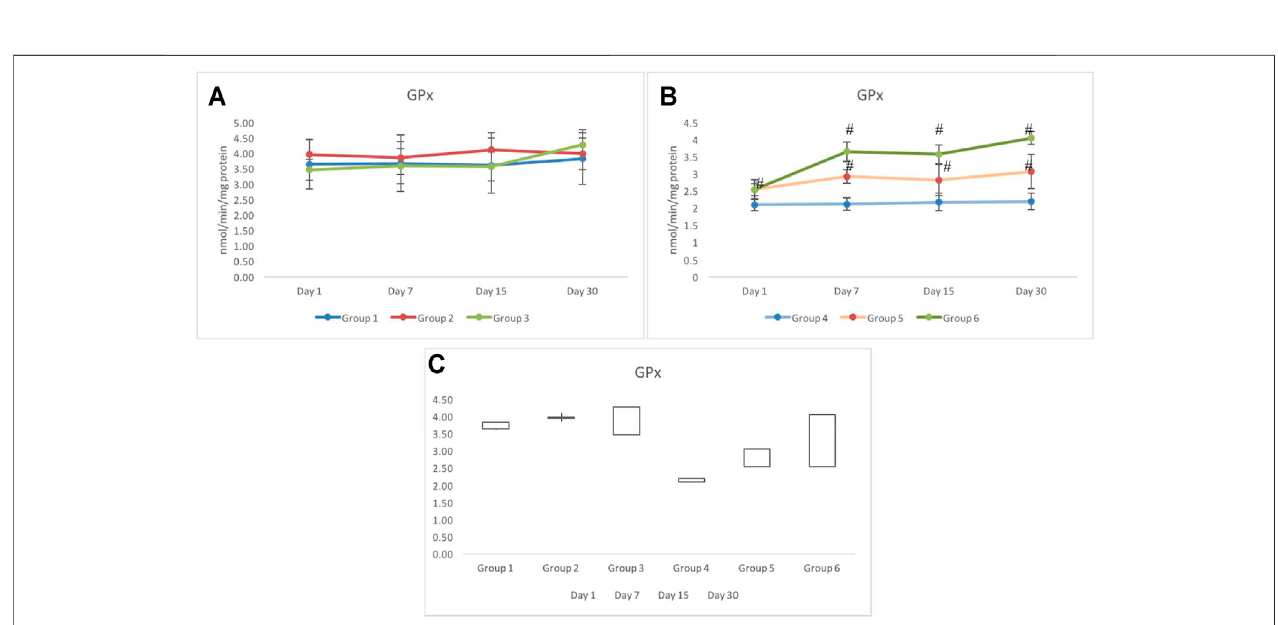
FIGURE7| Variationintheactivityofglutathioneperoxidase(GPx)innon-exposed (A) andexposed (B) groupsbasedonpretreatmentwithCRE/CRE-AgNPs. (C) indicating the stock plot indicating the gain/loss of activity on GPx from day 1 to day 30 of investigation. * p < 0.05 signi fi cance level was measured against group 1. # p < 0.05 signi fi cance level was measured against group